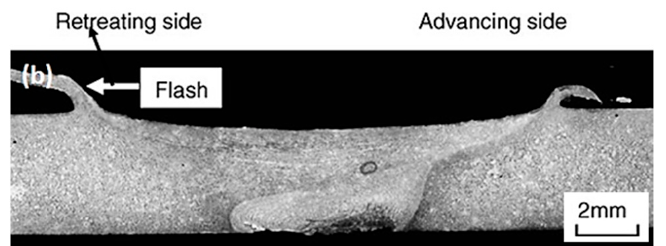
Figure 10. Surface defects in FSW butt joint ( a ) roughness display of weld from [61], ( b ) flash on the surface of the joint [130]. Figure 10a reprinted from: On the fatigue behavior and design curves of friction stir butt-welded Al alloys. International Journal of Fatigue 27, no. 3 (2005): 305–316, Lomolino, S., R. Tovo, and J. Dos Santos, Copyright 2005, with permission from Elsevier. Figure